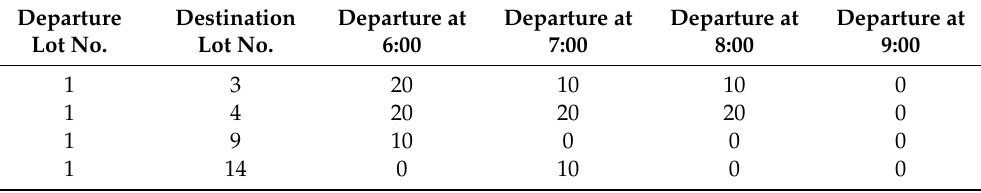
Table 3. Sample statistics of travel volume at each hour and at each plot.